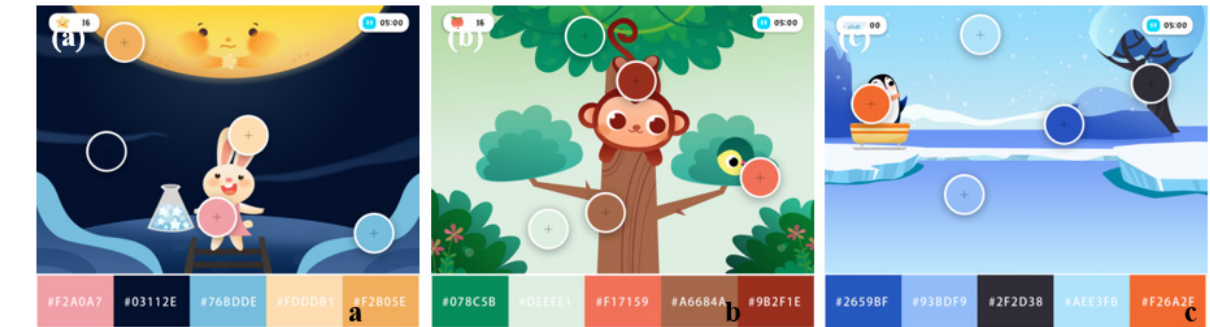
Figure 11. Visual interfaces for different game scenarios. ( a ) Visual interface of the alerting game. ( b ) Visual interface of the orientation game. ( c ) Visual interface of the executive control game. (Authors’ proposal).